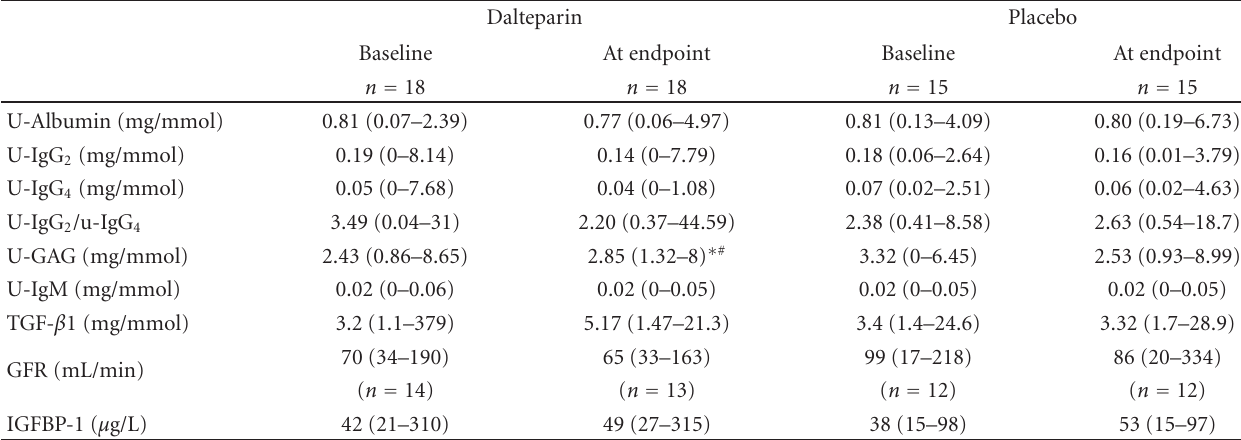
Table 3: Diabetic patients with normoalbuminuria: e ff ects of treatment on urinary indices. Dalteparin Placebo